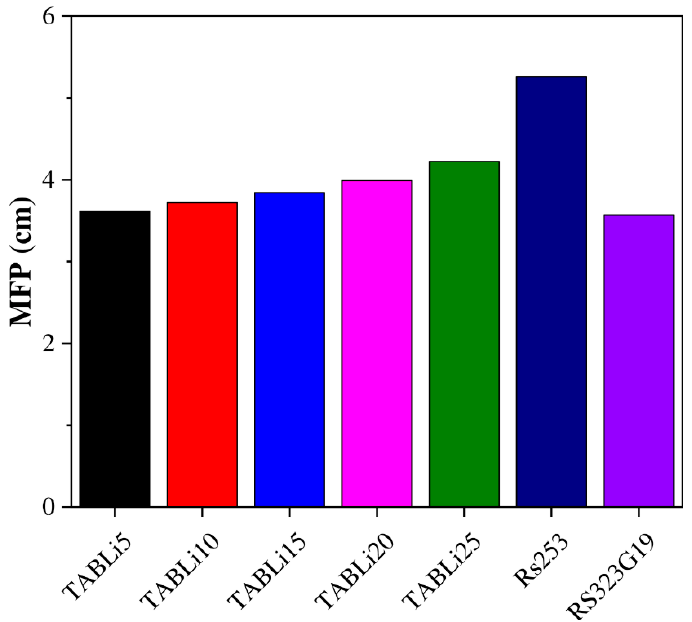
Figure 10. Comparison between the MFP of the studied glasses with some known commercial glasses (RS253 and RS323-G19).